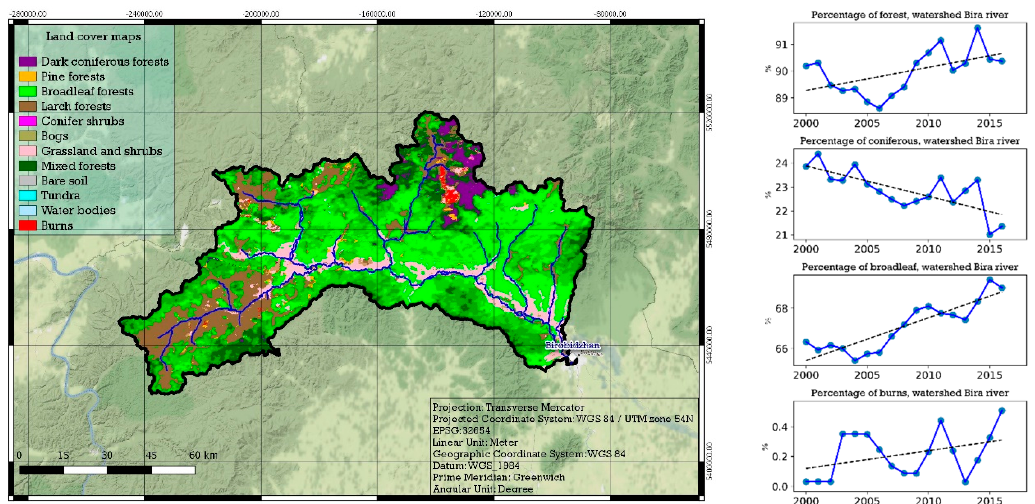
Figure 10. Vegetation dynamics of Bira River watershed. Stream gaging is marked with the white diamond.